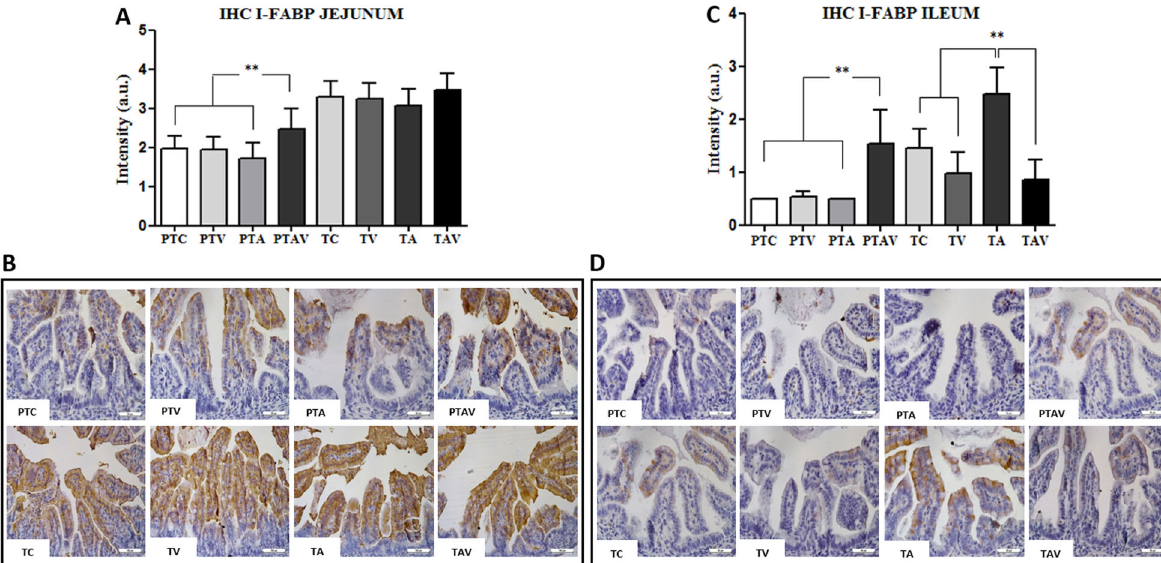
Figure 4. Immunohistochemistry (IHC) results of the fatty acid-binding intestinal protein (I-FABP) expression in newborn rats. A , IHC arbitrary units (a.u.) of I-FABP in the jejunum. B , IHC photomicrographs of jejunum. Observe the increased I-FABP immunostaining in the PTAV subgroup compared to all PTsubgroups. C , IHC arbitrary units (a.u.) of the I-FABP expression in the ileum. D , IHC photomicrographs of ileum. Observe increased I-FABP immunostaining in the PTAV subgroup compared to all PT subgroups (top images), and increased I-FABP immunostaining in TA subgroup compared to all T subgroups (bottom images). PTC: preterm control; PTV: preterm ventilated; PTA: preterm asphyxiated; PTAV: preterm asphyxiated and ventilated; TC: term control; TV: term ventilated; TA: term asphyxiated; TAV: term asphyxiated and ventilated. Magni fi cation: 200 (cid:1) ; scale bar: 50 m m; n=4. **P o 0.005, Kruskal-Wallis test followed by the Dunn post-test.